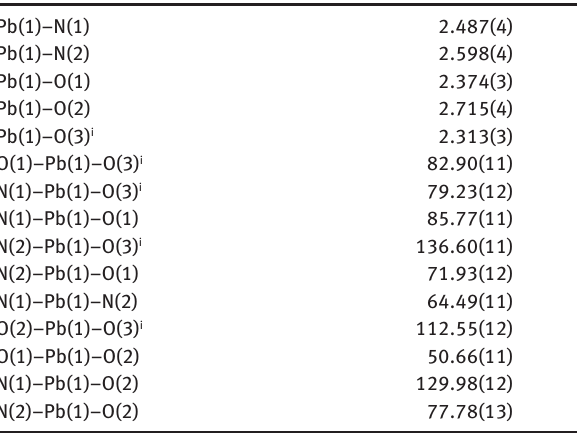
Figure 1: View of the coordination environment of the Pb(II) atom of 1 .